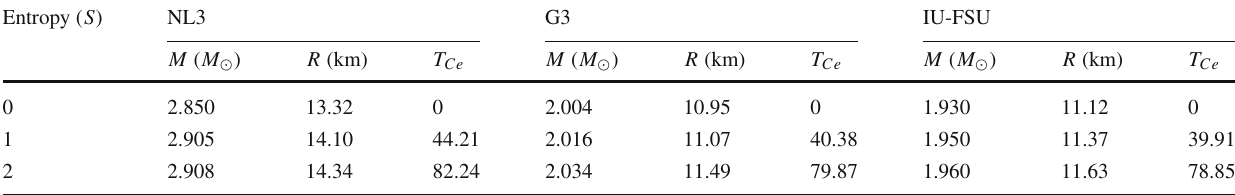
Table 2 Maximum mass and radius of the PNS for NL3, G3 and IU-FSU parameter sets calculated using constant entropy EoS for S = 0, 1 and 2. T Ce denotes the central temperature of the PNS Entropy ( S ) NL3 G3 IU-FSU M ( M (cid:6) )